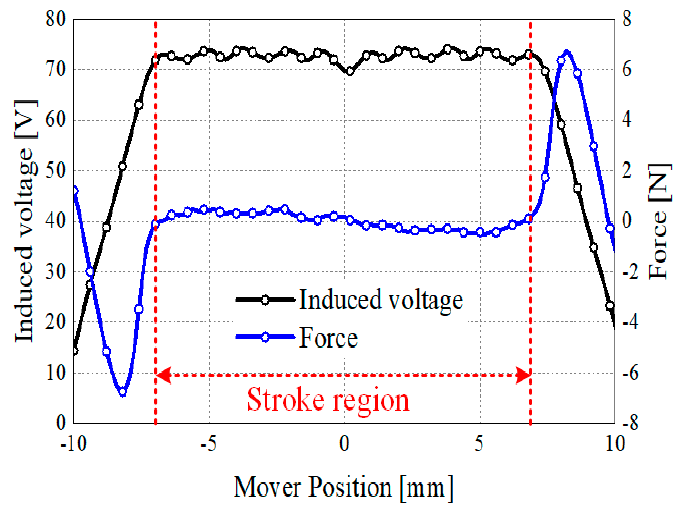
Figure 3. Back EMF and magnetic force according to mover position.